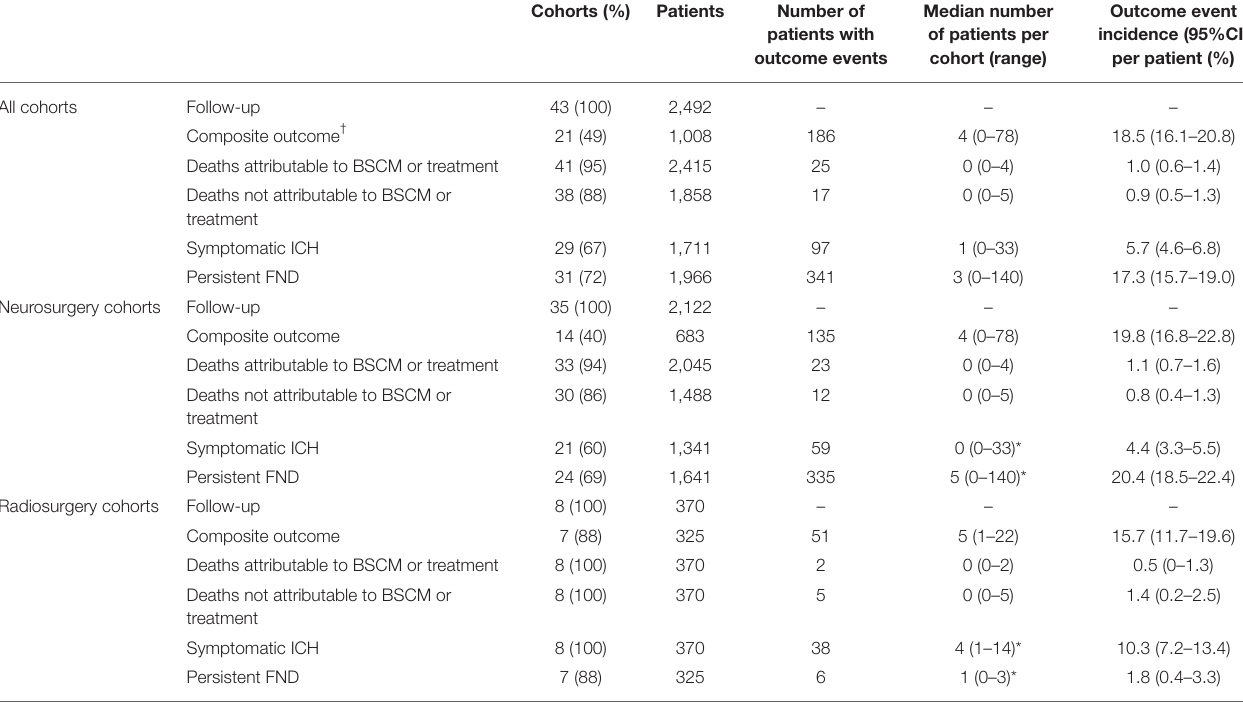
Cohorts (%) Patients Number of